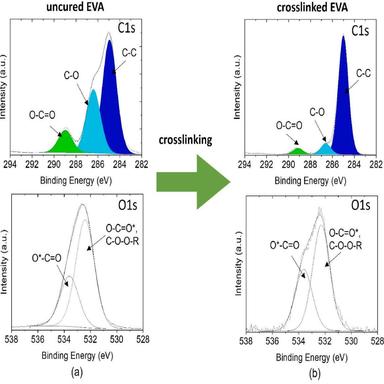
XPS HR spectra of an EVA encapsulant in the (a) uncured and (b) crosslinked state.